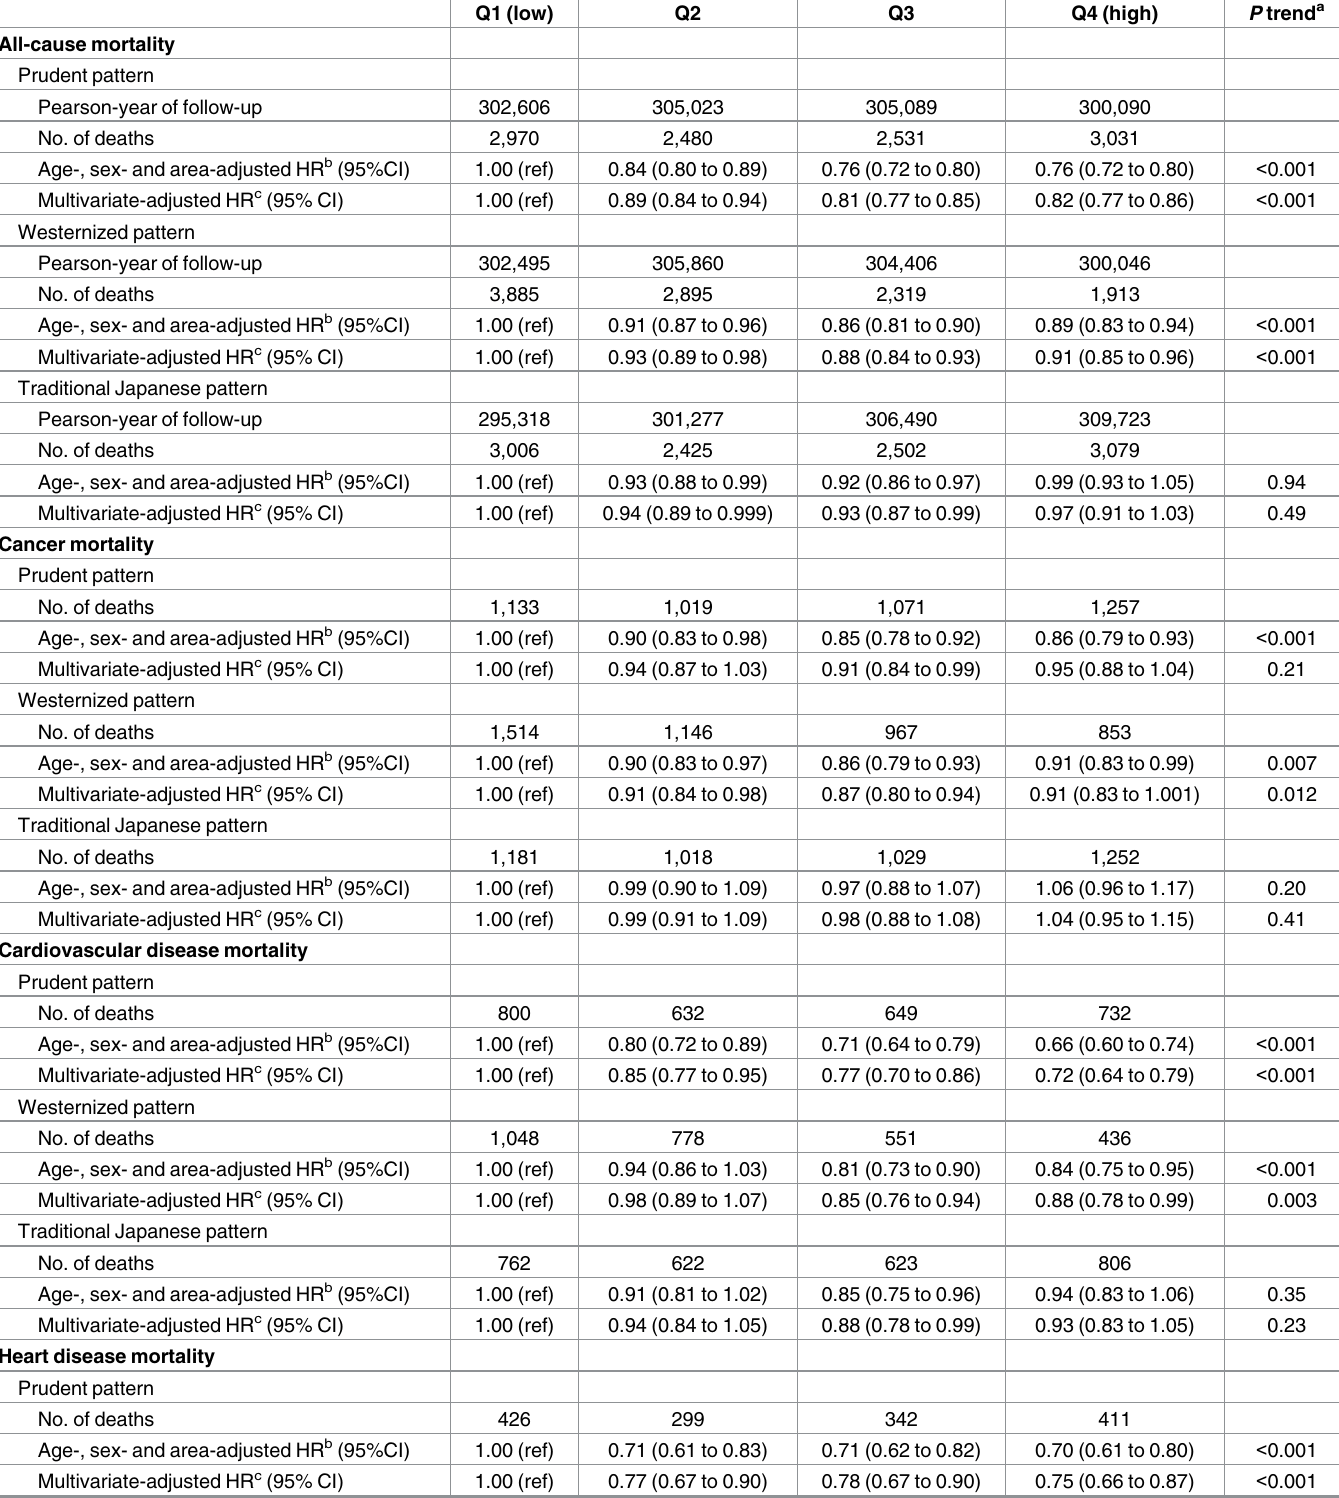
Table 3. Hazard ratios (95% CI) for all-cause, cancer, and cardiovascular disease mortality according to quartile (Q) of dietary pattern